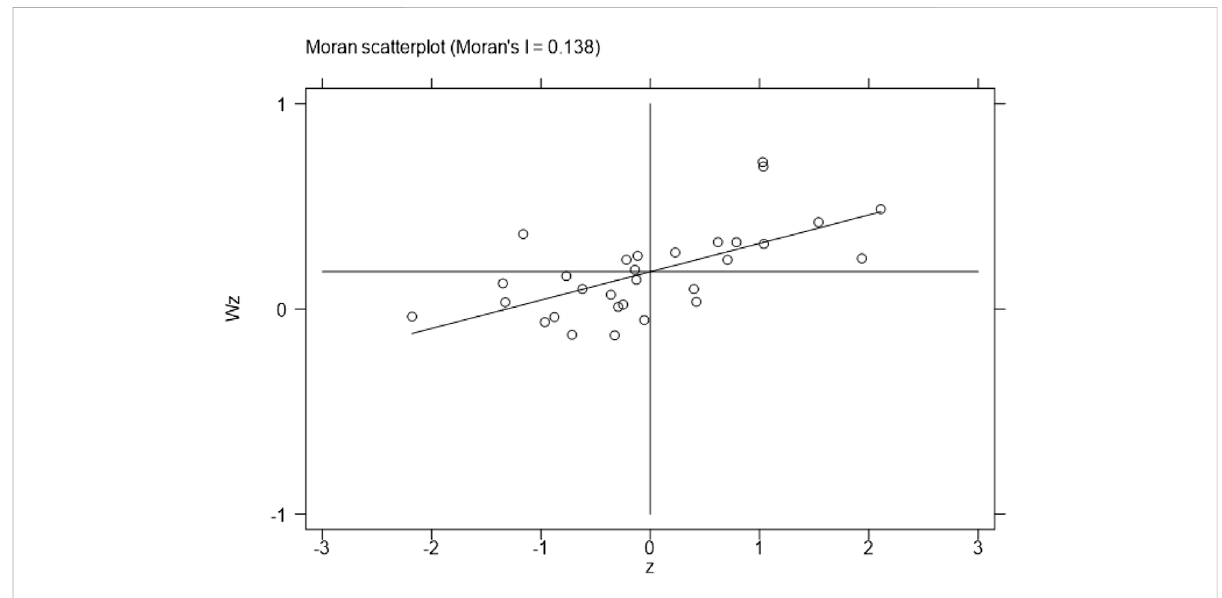
FIGURE 1 LISA map of regional atmospheric contamination in 2005.